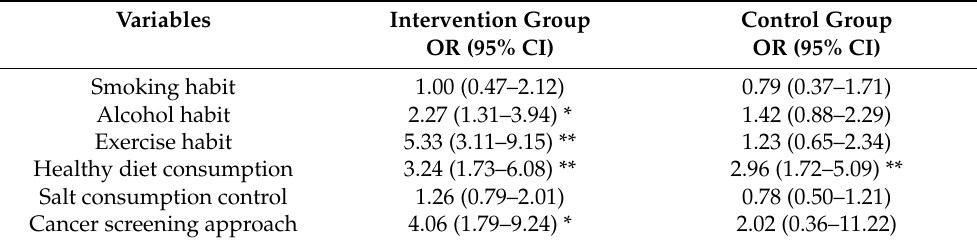
Table 4. Logistic regression on the change of healthy practice in 3-months among knowledge-sharing